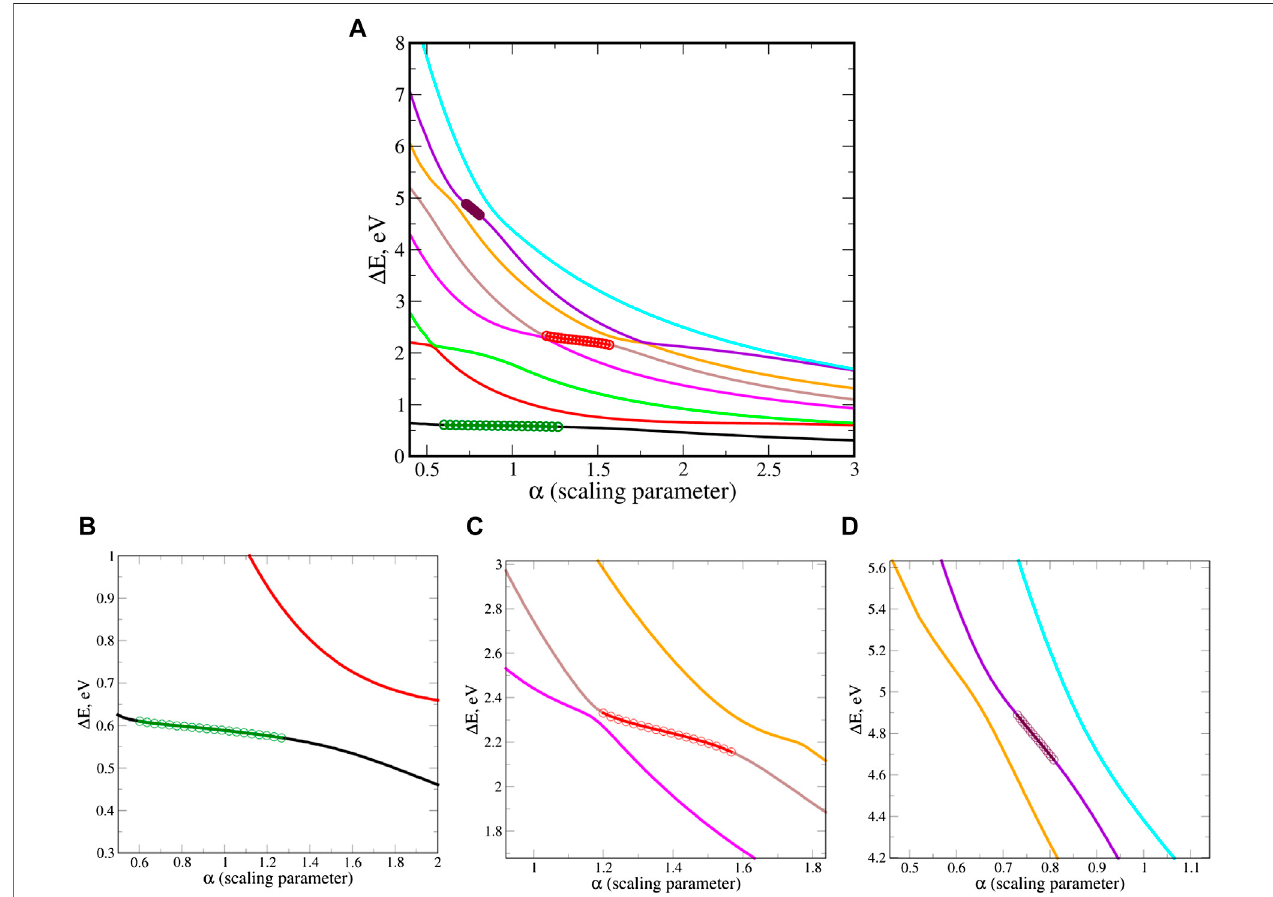
[66], with the permission of AIP Publishing.